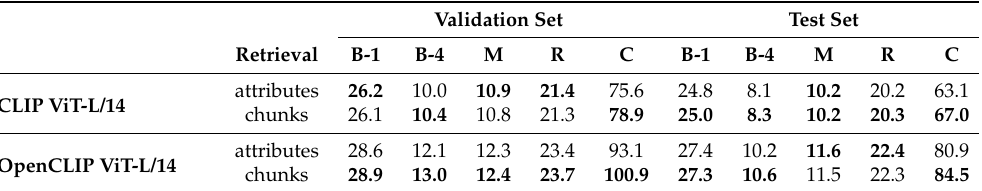
Table 1. Ablation study results on the FACAD validation and test splits using different retrieval strategies. Validation Set Test